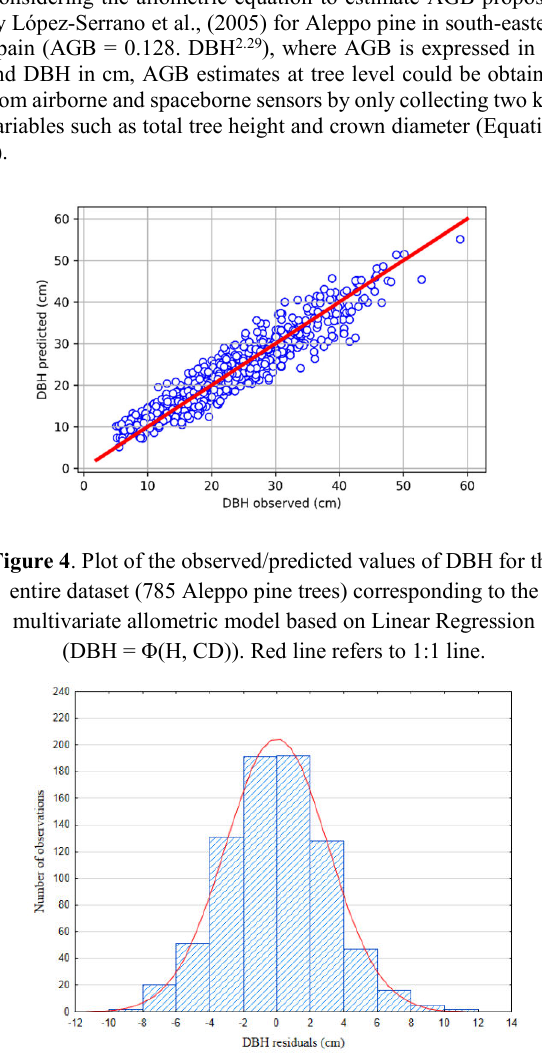
Figure 5 . Histogram of the DBH residuals for the multivariate linear allometric model (DBH = Φ(H, CD)). The corresponding normal distribution is overlaid in